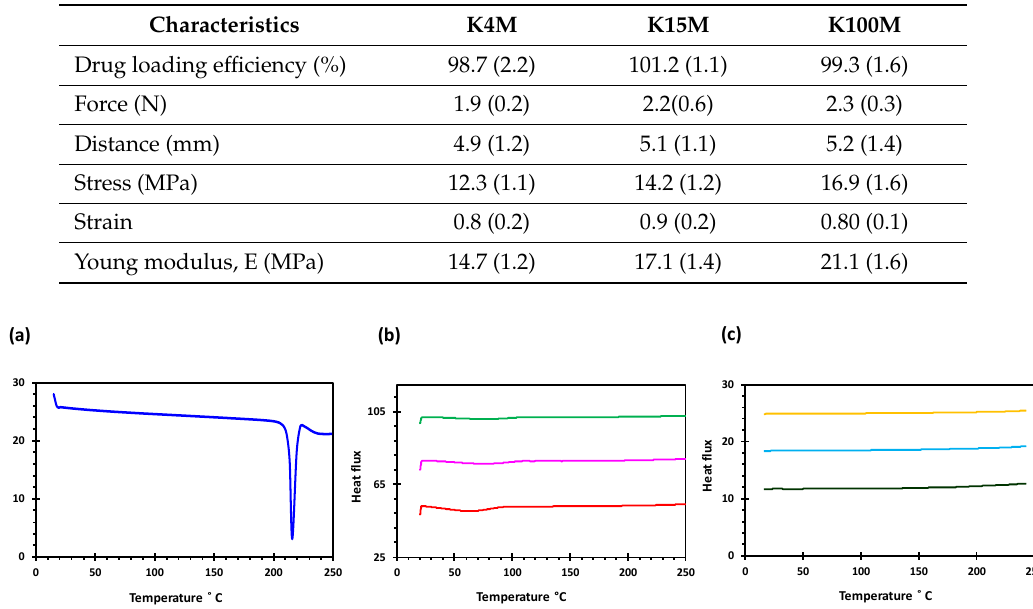
Figure 3. TGA profiles of ( a ) glipizide, ( b ) HPMC (K4M, K15M and K100M) and ( c ) K4M/GLP, K15M/GLP and K100M/GLP filaments.